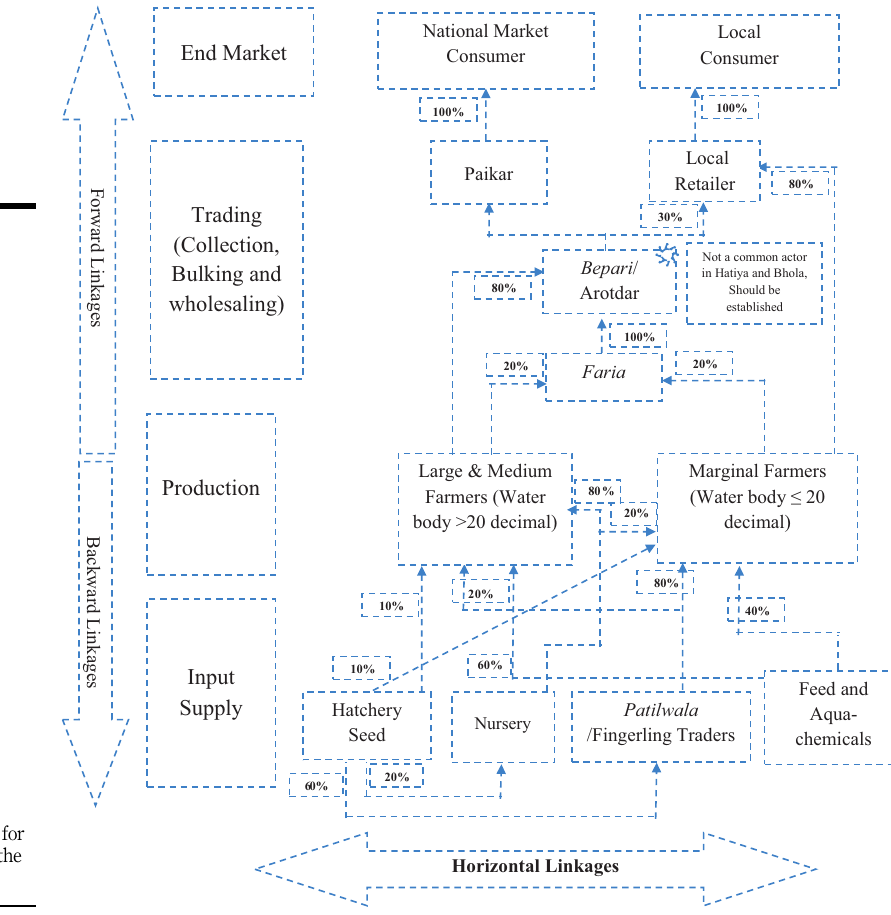
Figure 4. value chain model for fisheries sector in the study